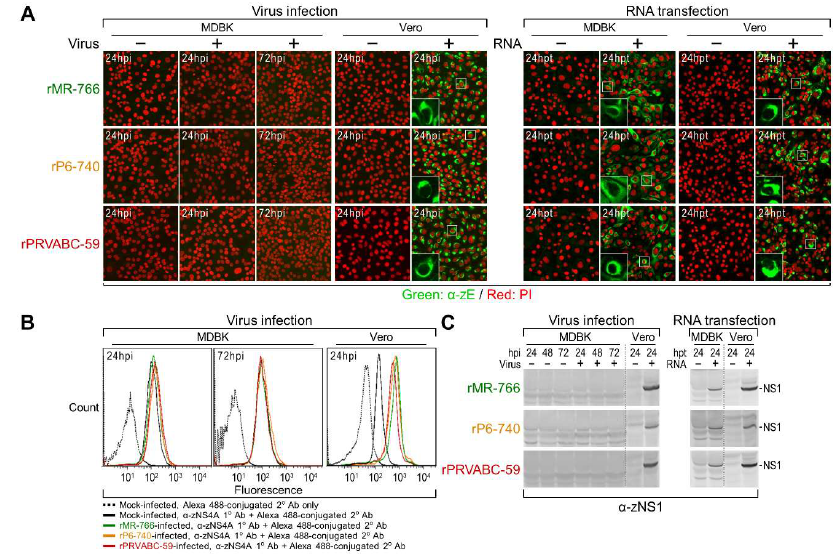
Figure 4. MDBK cells are permissive for ZIKV RNA replication but are not susceptible to infection with the virus. MDBK cells were mock-infected or infected with rMR-766, rP6-740, or rPRVABC-59 at an MOI of 3 (for virus infection experiments), or mock-transfected or transfected with 3 µ g of synthetic RNAs transcribed in vitro from their respective infectious cDNAs (for RNA transfection experiments). At the indicated time points, the expression of three ZIKV proteins (E, NS1, and NS4A) within the cells was analyzed by confocal microscopy for E ( A ), flow cytometry for NS4A ( B ), and immunoblotting for NS1 ( C ). The insets in panel A show enlarged views of the boxed areas with the fluorescence of propidium iodide (PI)-stained nuclei excluded. In all experiments, ZIKV-susceptible Vero cells were included in parallel. hpi, hours post-infection; hpt, hours